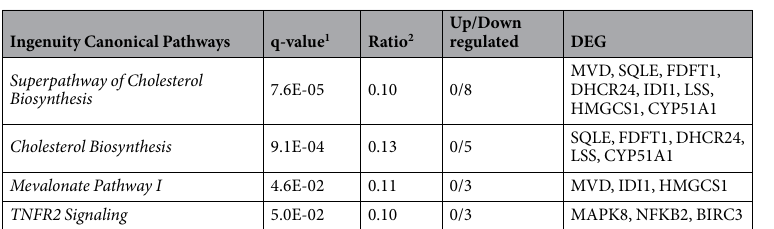
Table 1. Top canonical and signaling pathways among Differentially Expressed Genes (DEGs) in response to energy restriction (NEB vs. PEB) with a q-value < 0.05 and a ratio > 0.1. 1 The q-value shows the significance of the enrichment of a function within the DEGs, adjusted by Benjamini and Hochberg’s FDR. 2 Ratio of DEGs/ number of genes in the